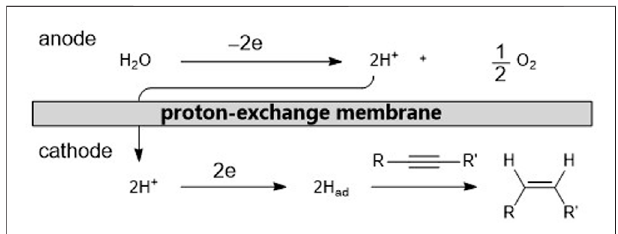
SCHEME 1 | Schematic of Alkyne Reduction in a PEM